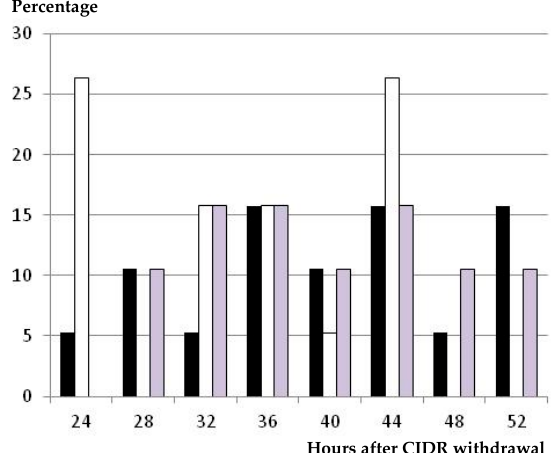
Figure 2. Distribution (percentage of animals) of time of onset of estrus behavior, in hours after CIDR withdrawal, in ewes treated with a single i.m. dose of 400 IU of eCG at CIDR removal (group CIDR-eCG, white bars), with a single dose of GnRH at 56 h after CIDR removal (group CIDR-GnRH, grey bars), and with two GnRH doses—one at CIDR insertion and one 56 h after CIDR removal (group GnRH-CIDR-GnRH, black bars).